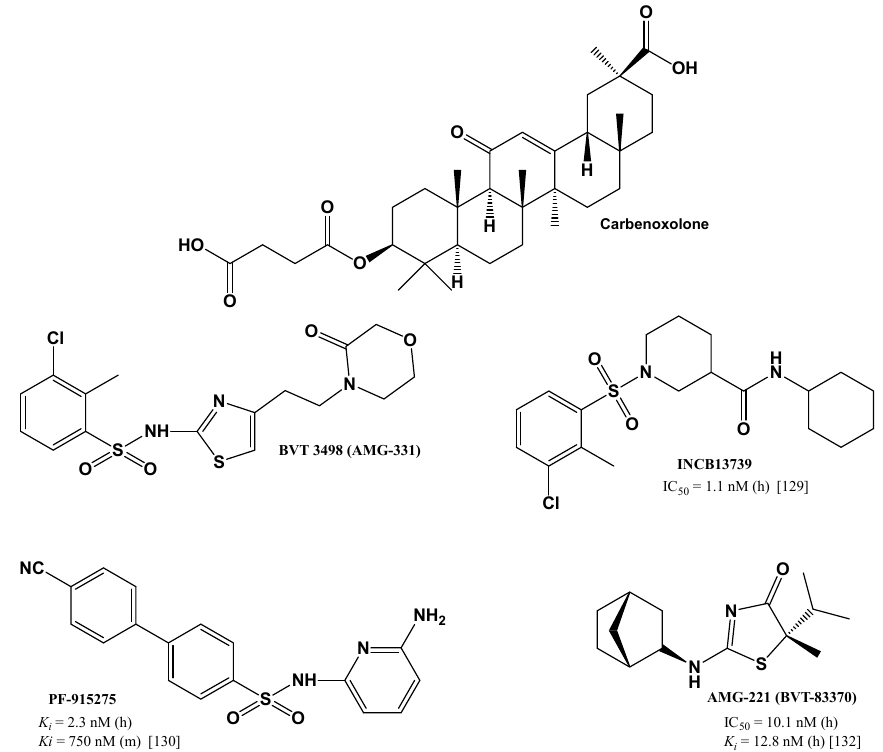
Figure 4. Carbenoxolone and selected selective 11 β -HSD1 inhibitors used in clinical trials: BVT-3498 (AMG-331), INCB13739, PF-915275, AMG-221 (BVT-83370). Data refer to tests for human (h) or murine (m) 11 β -HSD1 [129,130,132].